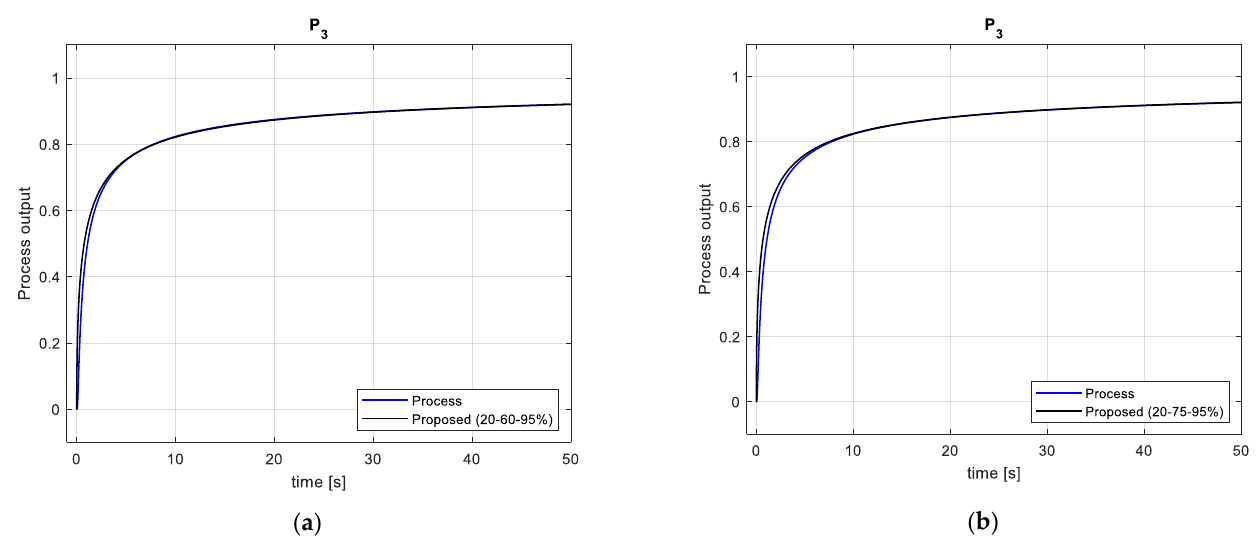
Figure 23. FFOPDT model step response using the proposed identification method for process P 3 and process reaction curve: ( a ) Asymmetrical set of points (20-60-95%); ( b ) Asymmetrical set of points (20-75-95%).